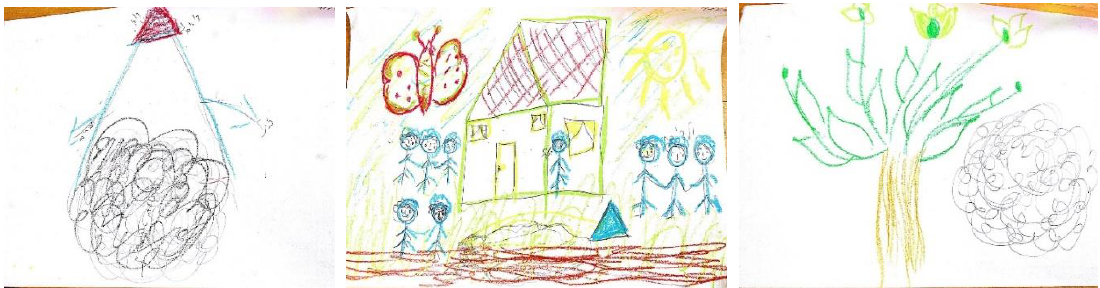
Figure 1. Selecting a new sheet of paper as the format for the integrative drawing.